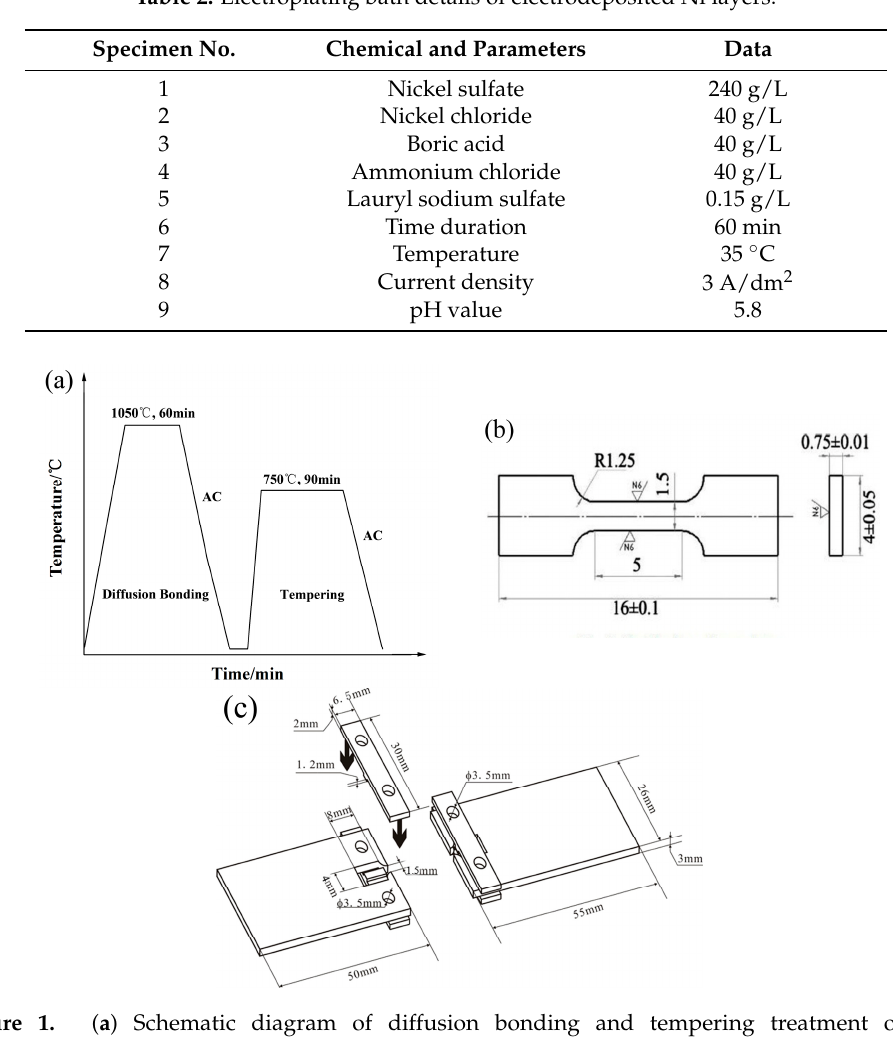
Table 2. Electroplating bath details of electrodeposited Ni layers.